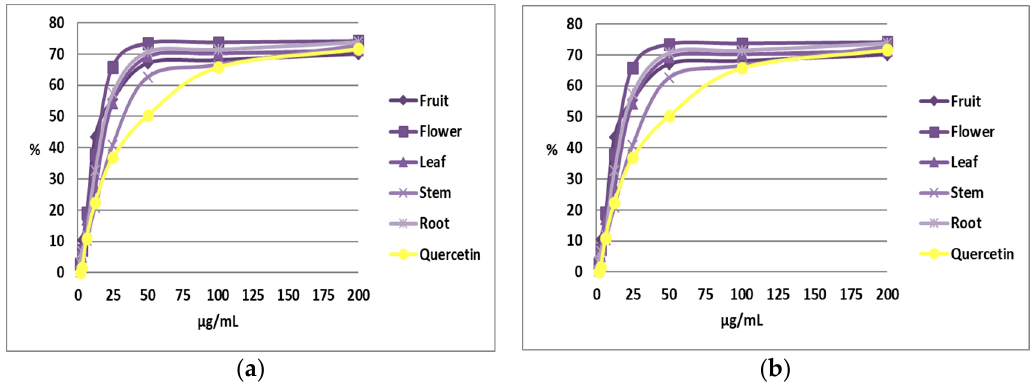
Figure 2. DPPH inhibition percentage of the methanolic N. alba fruit, flower, leaf, stem, and root extracts after 20 min of incubation ( a ); and after 50 min of incubation ( b ).